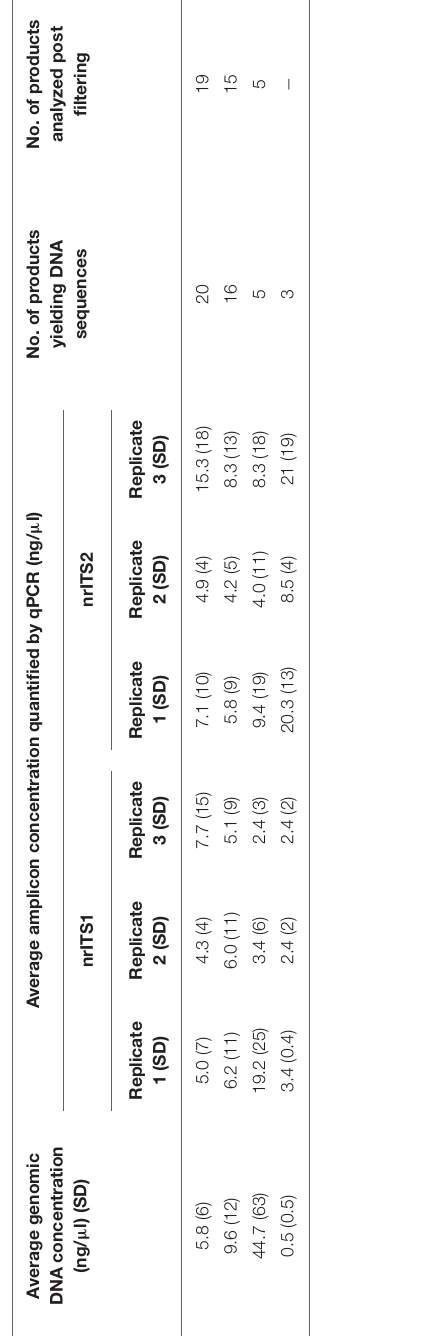
label but contained several other non-listed species. Out of